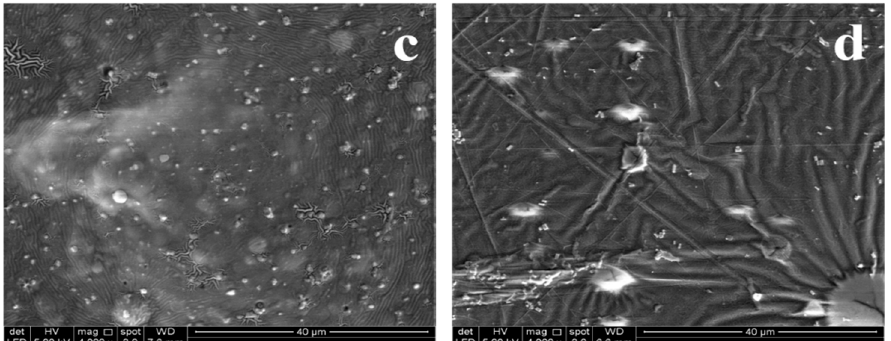
Figure 3. Surface SEM visualization of the probiotic and synbiotic edible films containing L. casei . ( a ) Syn-DFG/SS, ( b ) Syn-DFG/GA, ( c ) Syn-DFG/Dex, and ( d ) Syn-DFG/Poly.